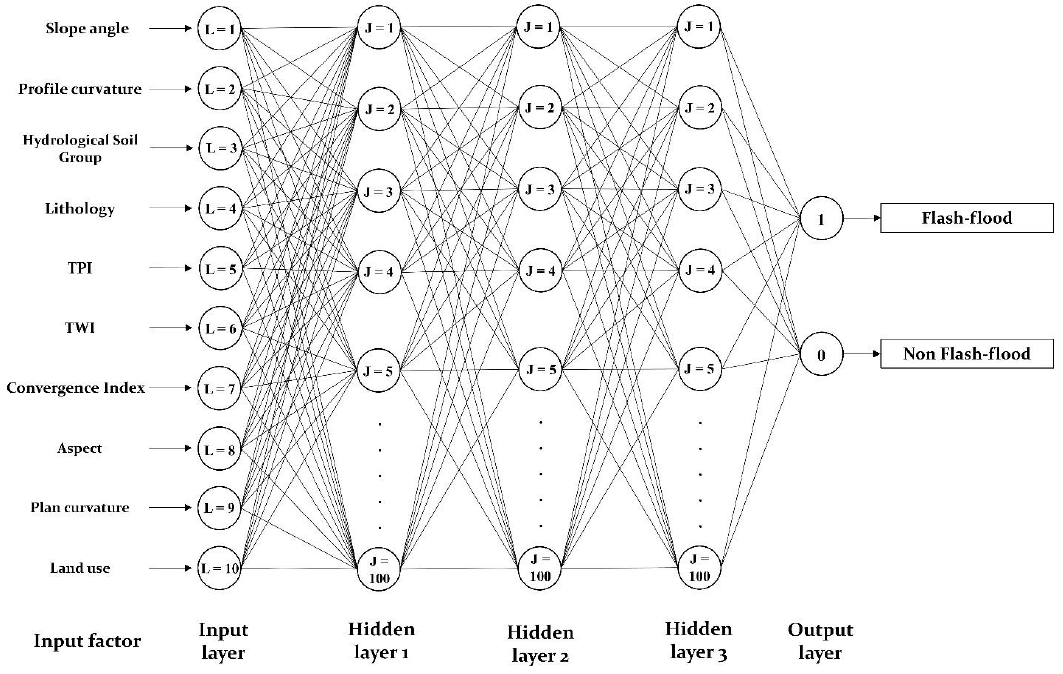
Figure 1. DNN architecture used in the present research.